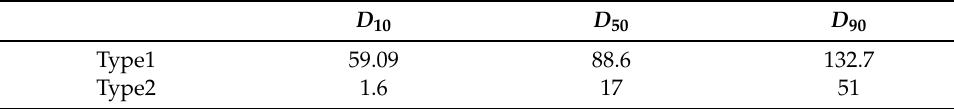
Table 2. D 10 , D 50 and D 90 in µ m for Type1 and